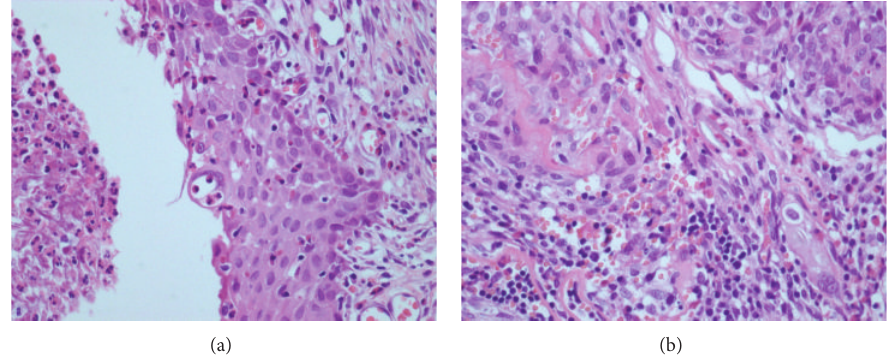
Figure 3: Grade 3 inflammation (presence of lymphocytes, plasmocytes, macrophages, and neutrophils) in a control eye (a) and an AM eye (b) with H&E stain and 400x magnification.